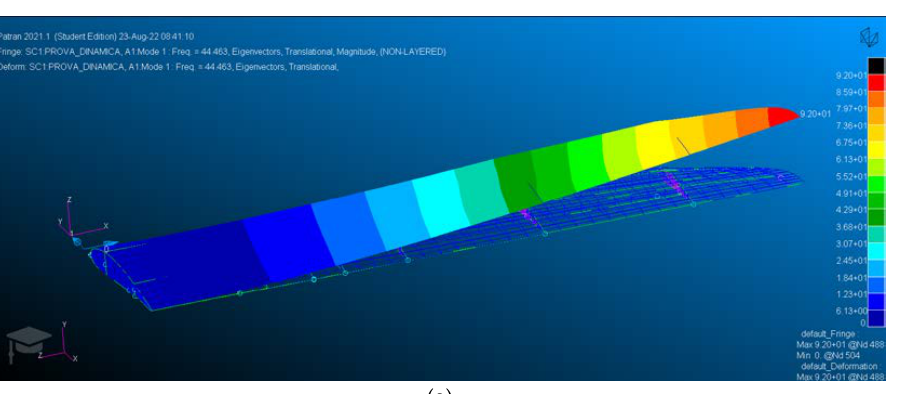
Figure 9. Percent strain energy of the first 20 mode shapes (and of the first residual vector, 21st among the calculated ones).